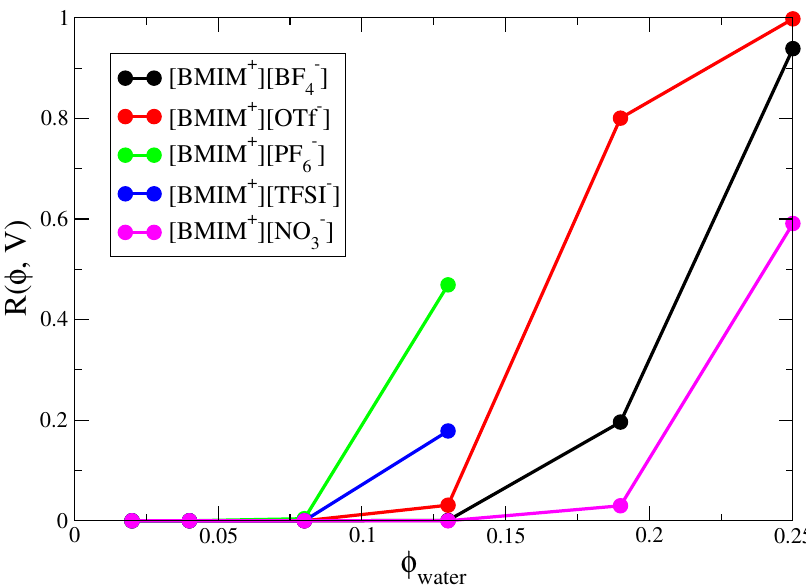
Figure 8. Percolation probability R ( φ , V ) as a function of water volume fraction, φ water , for IL/water